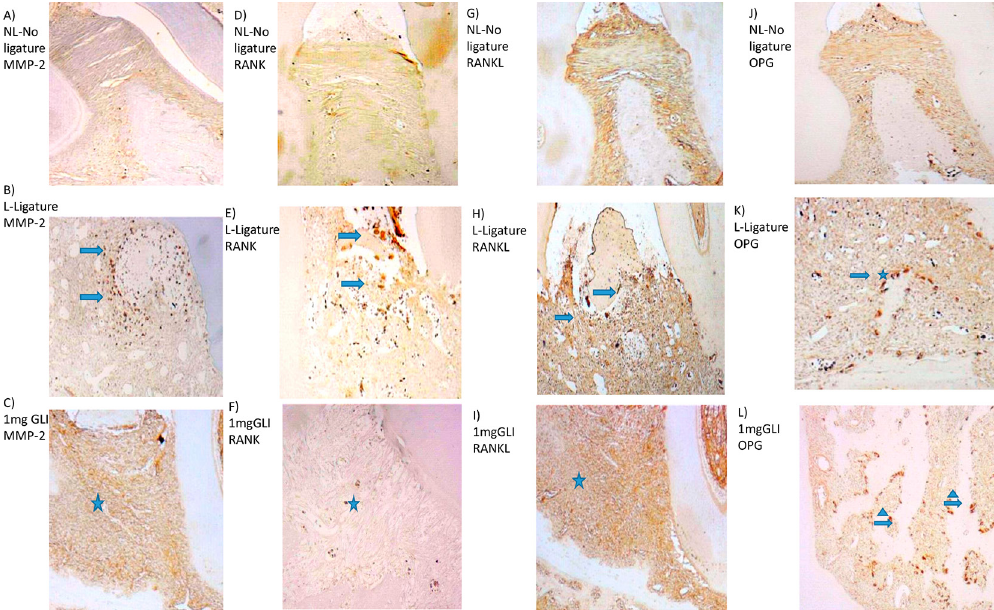
Figure 4- Photomicrographs of periodontal tissue from rats with periodontal disease treated with 1 mg/kg gliclazide (GLI) and control groups (no ligature and ligature), showing immunoreactivity to MMP-2, RANK, RANKL, and OPG. (A, D, G, J) Rats with no ligature. (B, E, H, K) Rats with ligature. (C, F, I, L) Rats with ligature treated with 1 mg/kg GLI. Arrow indicates high or moderate labeling in inflammatory cells in periodontal ligament or alveolar bone. Asterisk and arrow indicates mild labeling in the periodontal ligament. Triangle and arrow indicate high labeling of osteoclasts. Asterisk indicates mild labeling in the periodontal ligament or alveolar bone. Images are shown at 40×